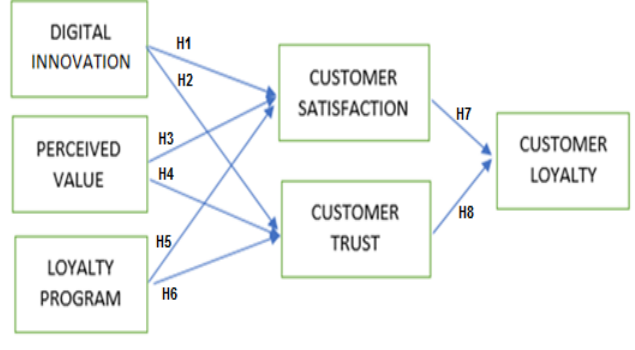
Figure 1: Research